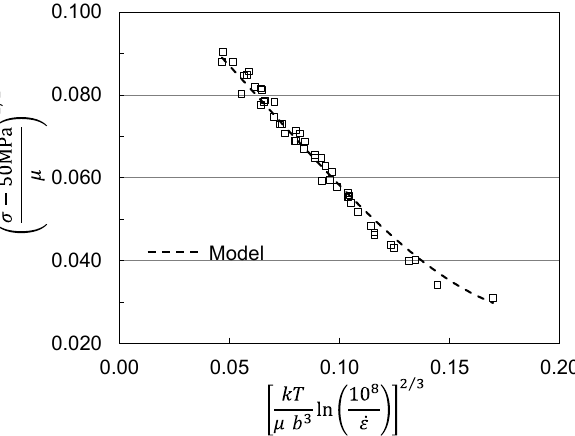
Figure 1. Briggs and Campbell measurements [9] in pure molybdenum analyzed according to Equations (2) and (3).